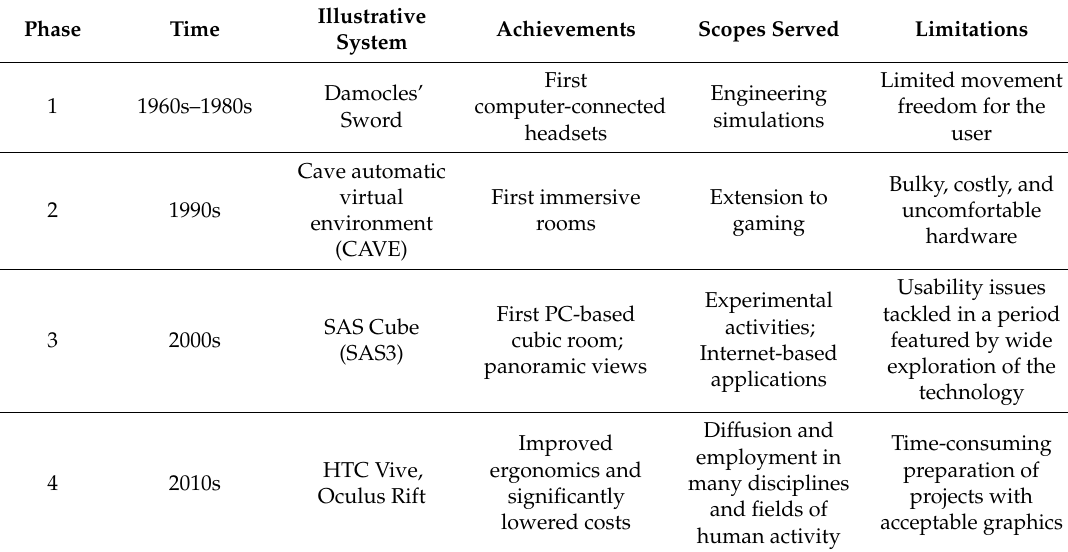
Table 1. Development phases of virtual reality (VR) technologies, along with characteristic advantages and limitations of the newly introduced